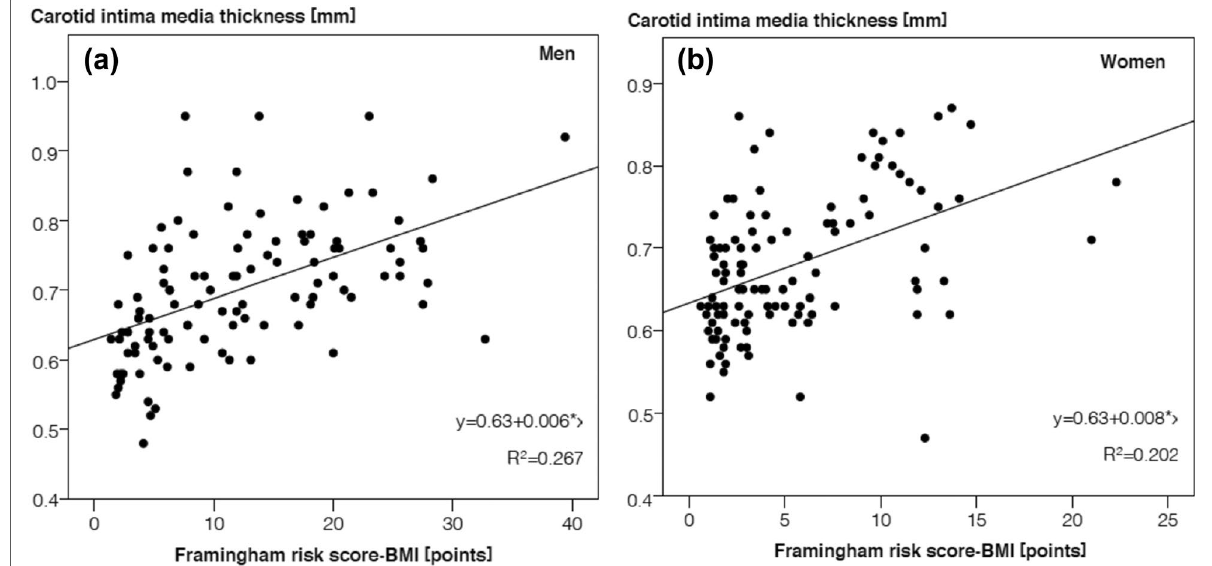
Fig. 1 Univariate linear regression analysis of Framingham Risk Score‑BMI and carotid intima–media thickness in men ( a ) and women ( b